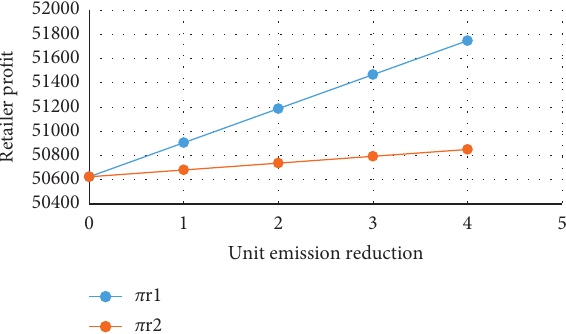
Figure 6: Manufacturer’s profit comparison chart.